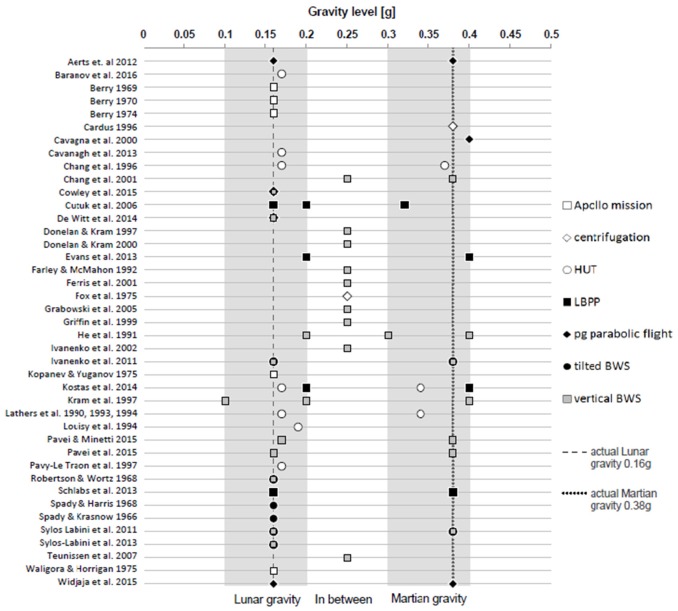
Gravity levels and simulation models of included studies. The ranges that were considered acceptable for Lunar- and Martian gravity in the present review are shown in gray. The exact values for Lunar and Martian gravity are depicted through dashed and dotted lines. Control conditions and measured gravity levels outside the defined range of 0.1–0.4 g are not shown. HUT, Head-up tilt; LBPP, Lower body positive pressure; BWS, body weight support system; pg, partial gravity.